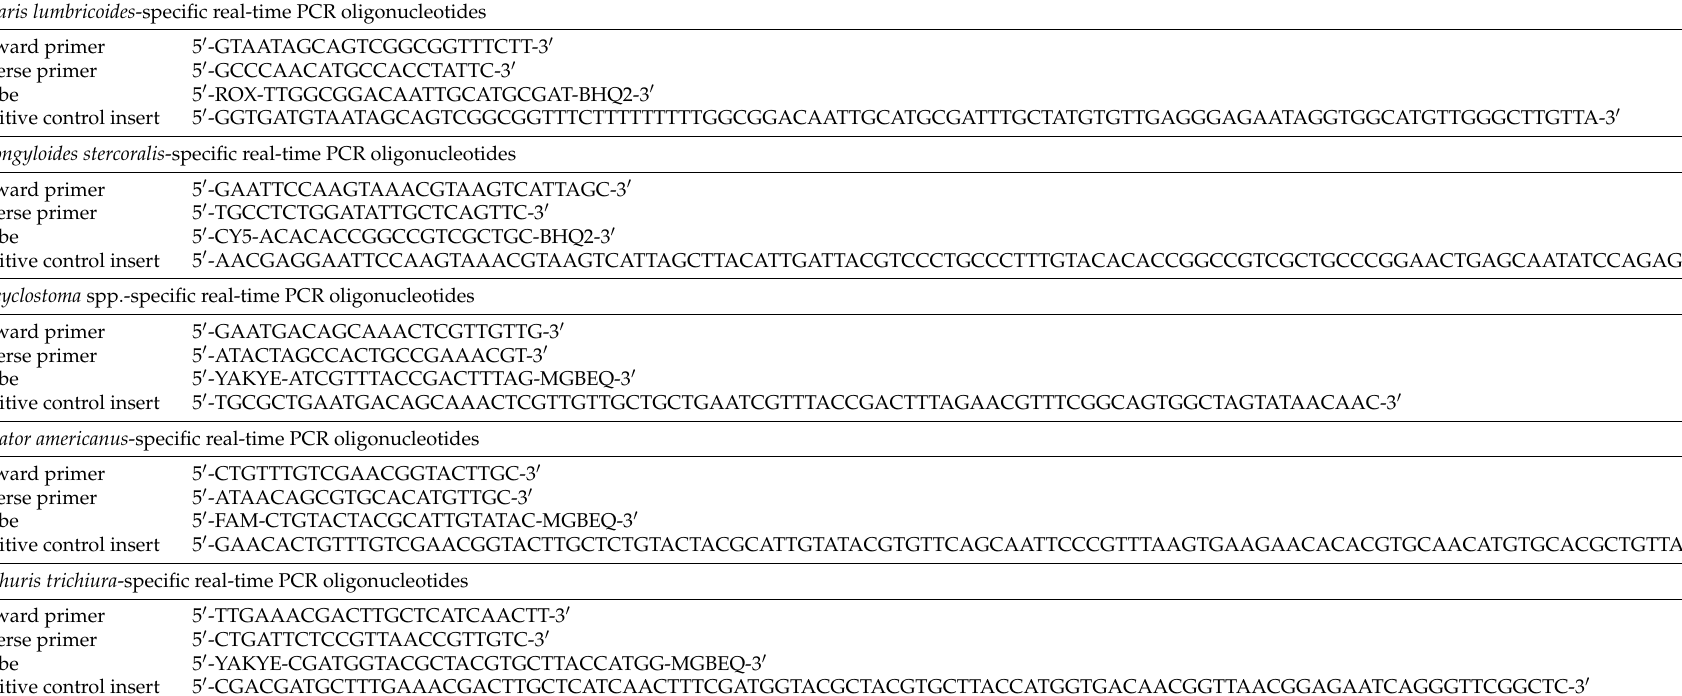
Table A1. Sequences of the primer and probe oligonucleotides (hybridization probes including the used reporter and quencher molecules) as well as of the positive control plasmid inserts of the applied helminth-specific real-time PCRs. The positive control plasmid inserts were included in pEX-A128 vector backbones (Eurofins Scientific SE,